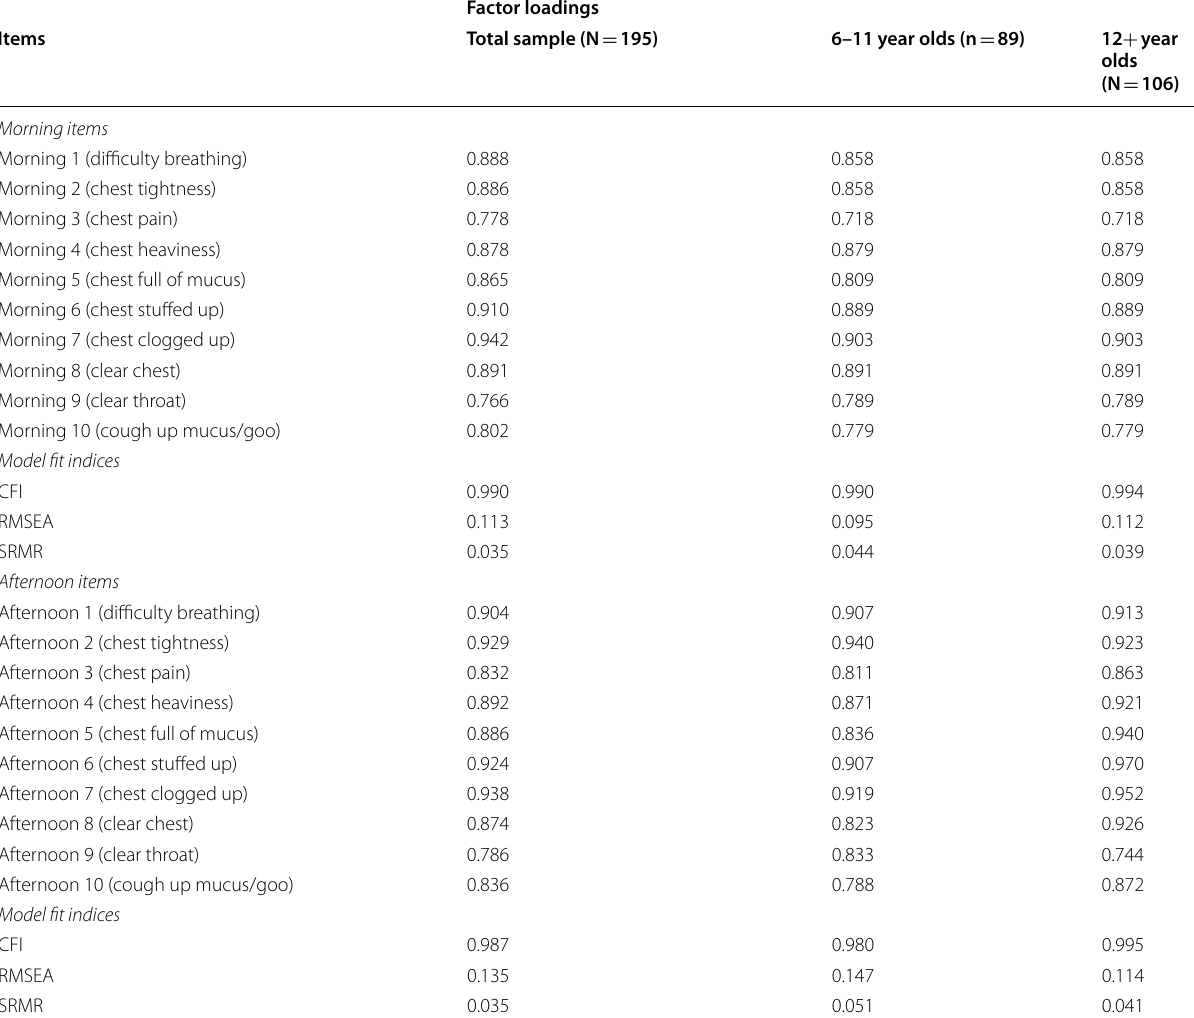
Table 4 Exploratory factor analysis of chest-related ePRO morning and afternoon diary